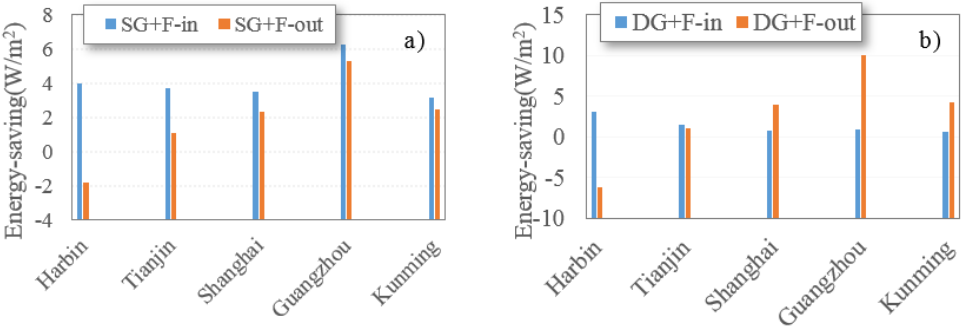
Figure 9. The energy-saving potential of SSAF: ( a ) SG+F; ( b ) DG+F.